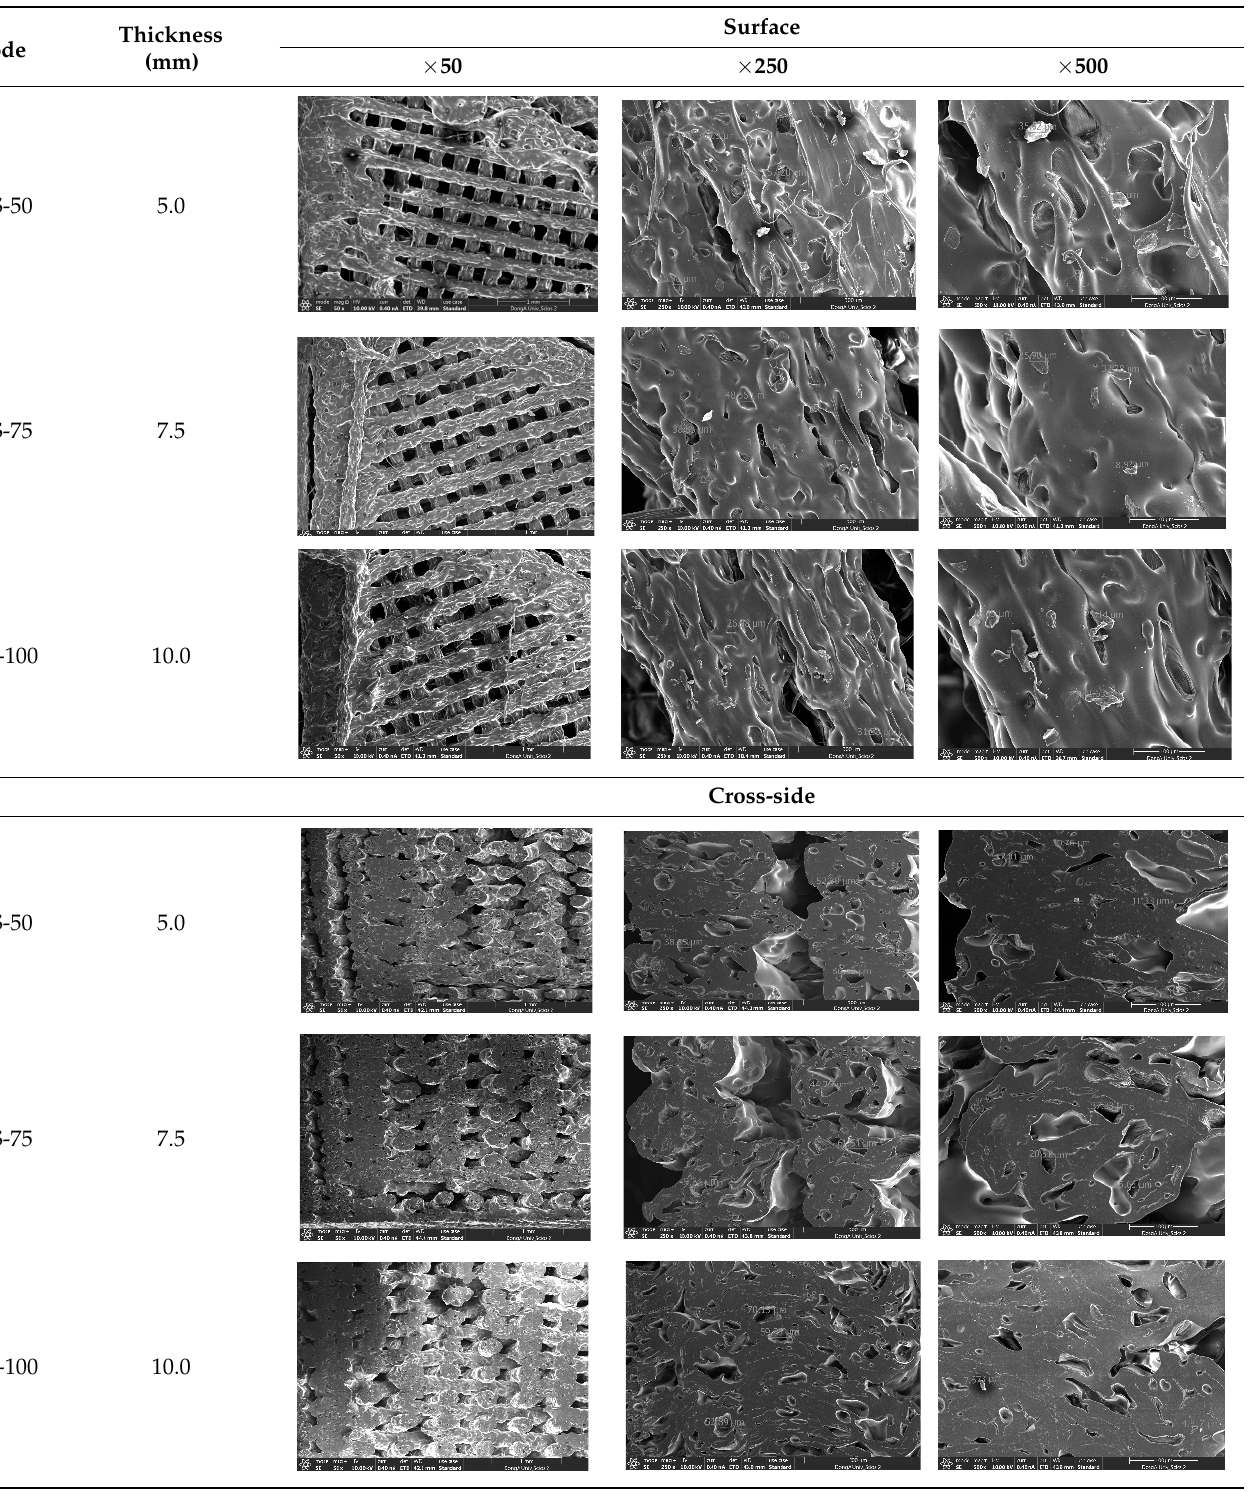
Table 4. Morphology image of surface and cross-side of the LW 3DP 6-PS outsole piece extruded in various thicknesses.